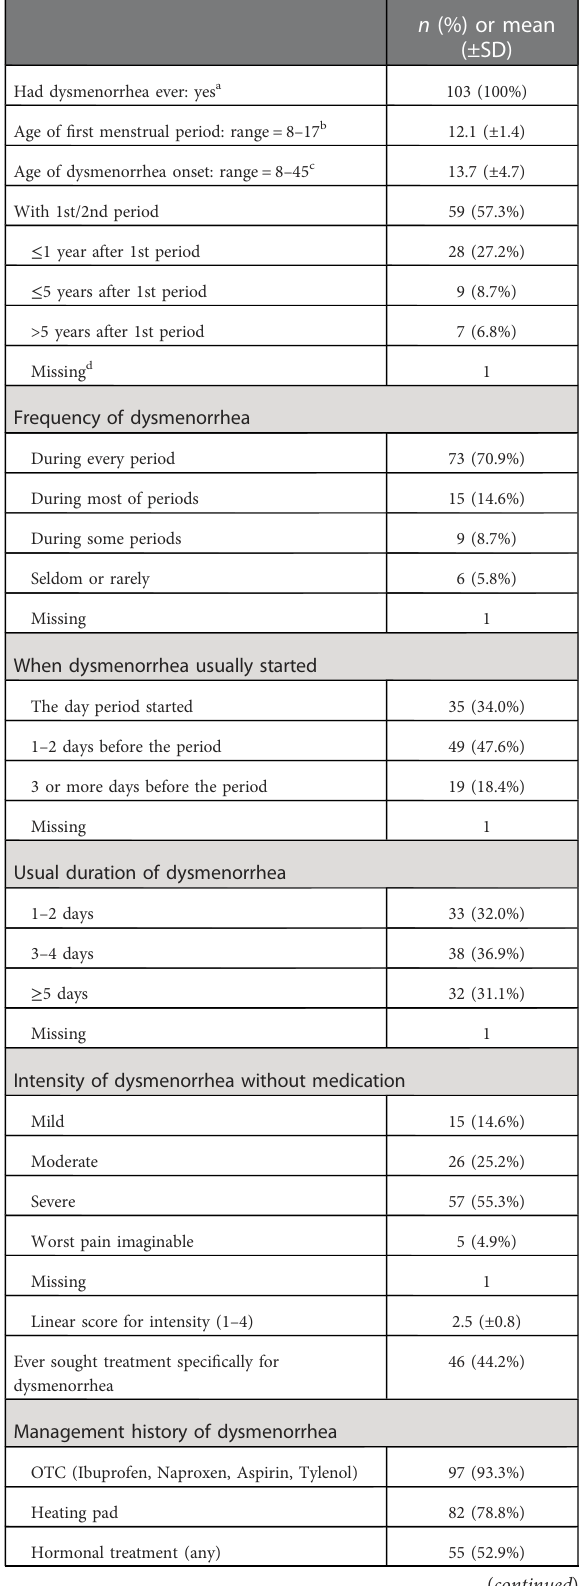
TABLE 2 Dysmenorrhea symptoms and treatment among the study sample ( n